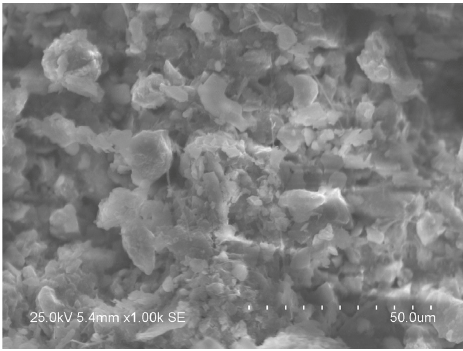
Figure 4: SEM image of the testing soil.